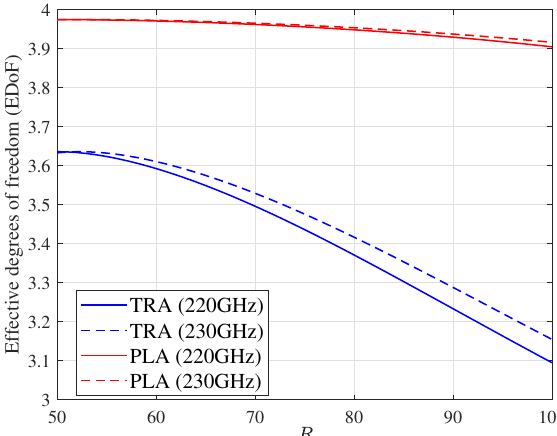
Figure 8. The comparison of EDoF for different R s and carrier frequencies with ¯ γ = 10 dB.